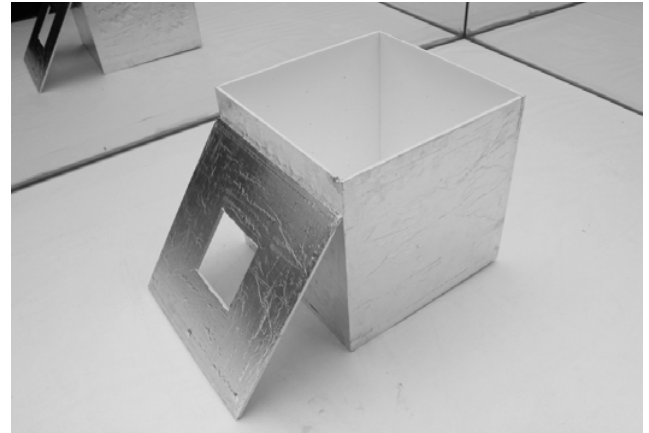
Figure 8. Model of calculation for artificial